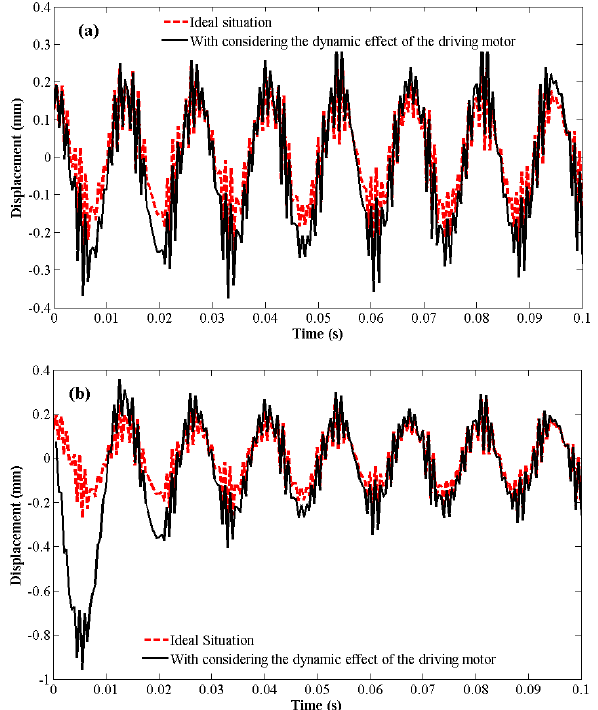
Figure 2. Vibration responses of the MDFMS under velocity (a) and acceleration (b) motions.